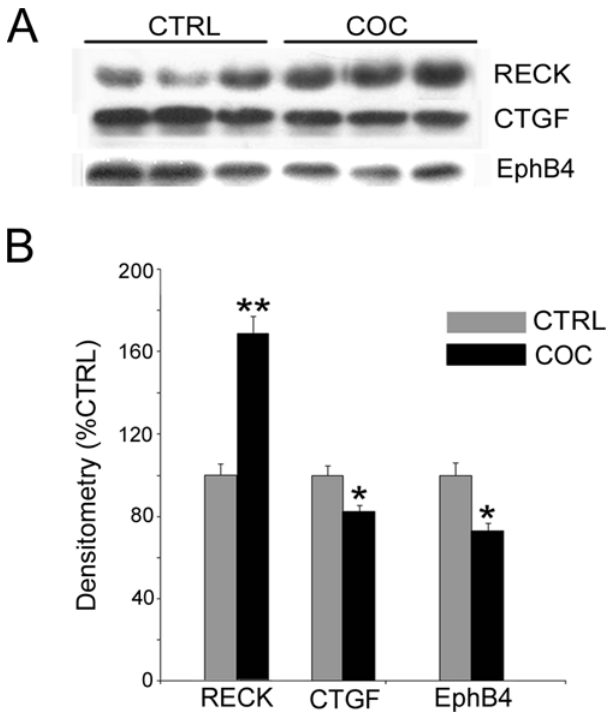
Figure 3. Confirmation of cocaine-regulated transcripts. A, RT-PCR confirmation of a sample of four genes (RECK, PCDH8, CTGF, EPHB4) in human hippocampus. Representative cases are shown. All genes were normalized to an endogenous control gene cyclophilin. B, Graphical representation of the relative mRNA levels (% of cyclophilin) in control and cocaine groups (n=8, respectively). ** p= 0.01 (one-tailed t-test), * p =0.05 (one-tailed t-test)